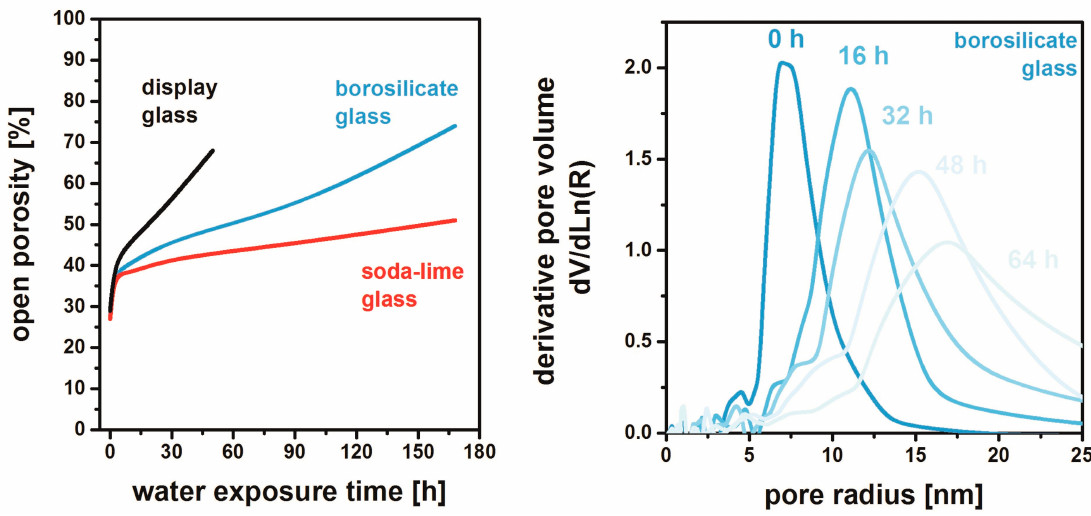
Figure 13. Open porosity of MgF 2 thin films deposited on different substrates as a function of exposure time to water ( left ) and the respective pore radius distributions of the samples from borosilicate glass ( right ). Based on [50].